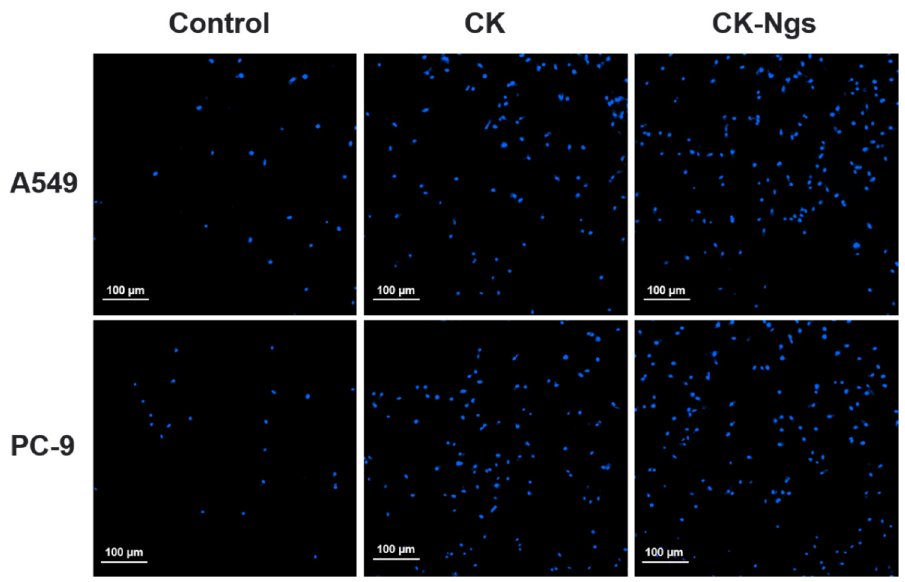
Figure 8. The cell apoptosis induction of CK and CK-Ngs in A549 and PC-9 cells were analyzed by Hoechst 33342 staining (Magnification 20× and scale bar is 100 μ m).